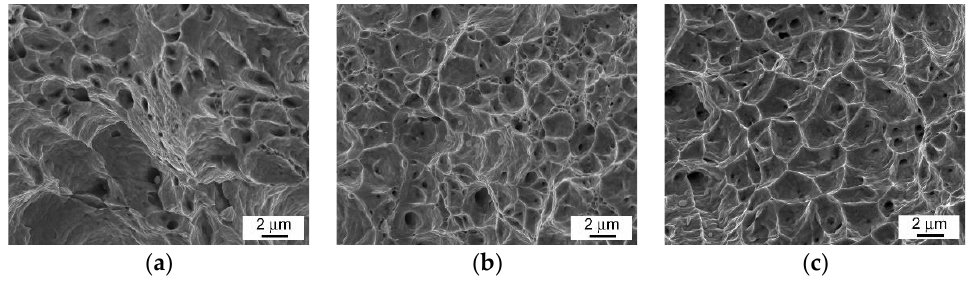
Figure 10. SEM-fractographs of fracture surfaces of broken tensile test specimens of studied 316H material in various material conditions: ( a ) as-received, non-hydrogenated; ( b ) as-received, hy-